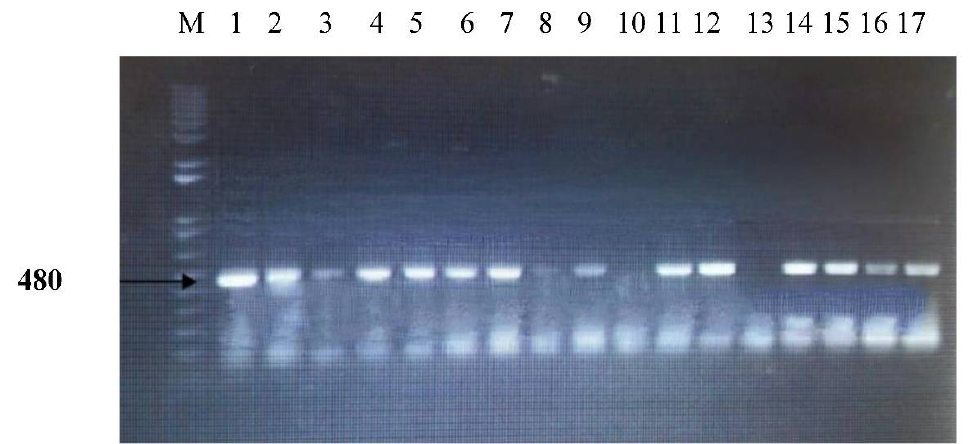
Figure 5. PCR products of the ITS-1 in an agarose gel electrophoresis M1 100 bp marker, lanes 1 to 7, 9, 11 to 12 and 14 to 17 T. evansi from positive samples in different locations.